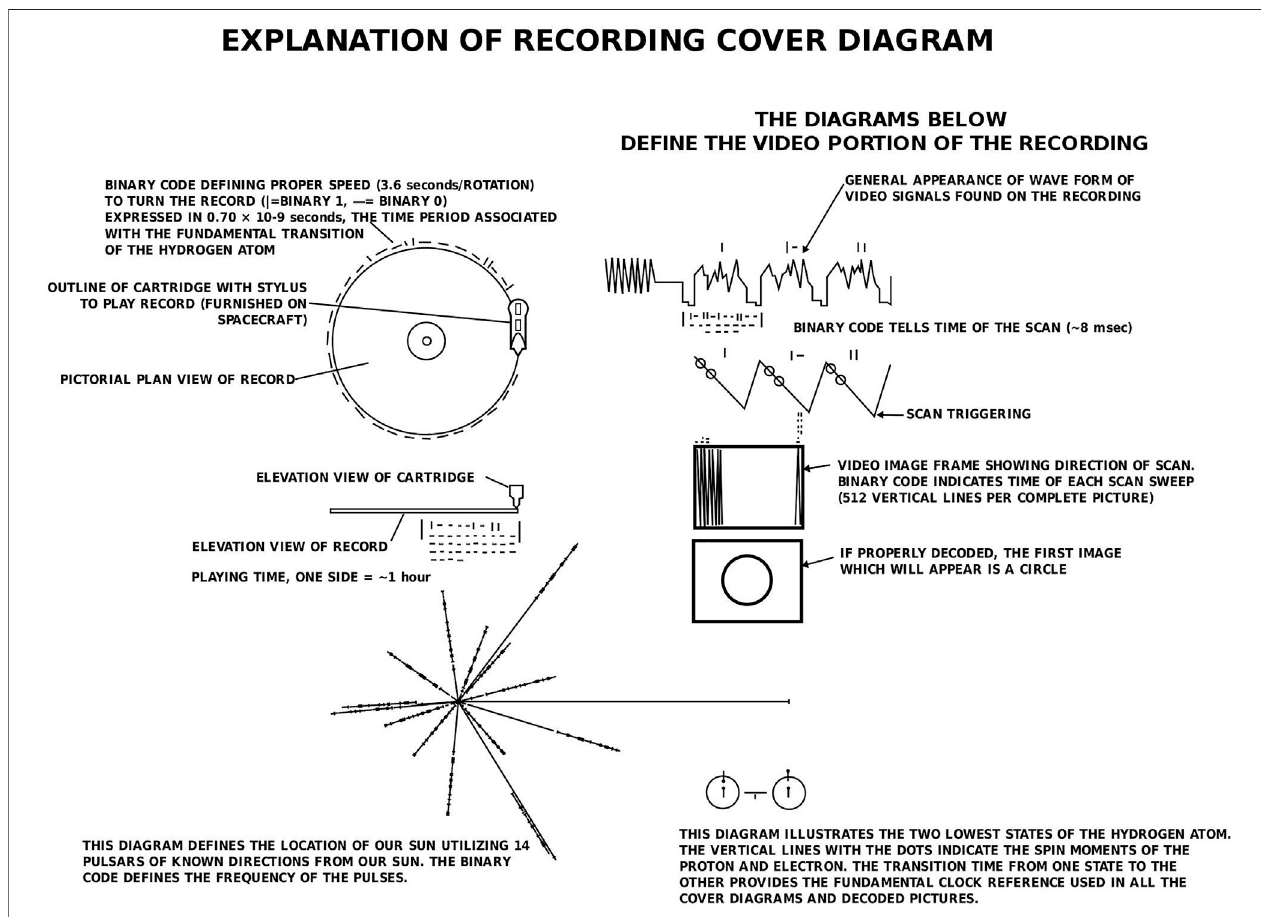
FIGURE 4 | Explanation of the voyager golden record cover diagram. Credit: NASA JPL.